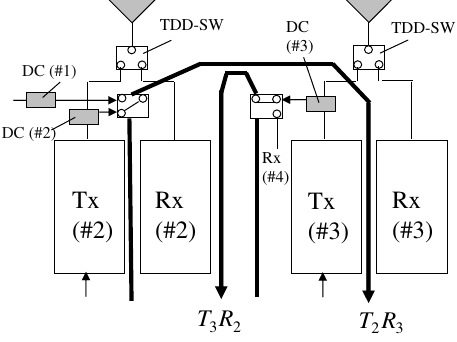
Figure 4. Calibration circuit for a large number of base station (BS) antennas. Tx: Transmitter. Rx: